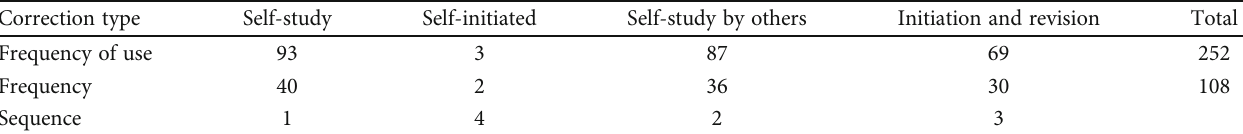
Table 4: Vocabulary emotion color correction types and frequency of use by advanced Chinese as second language